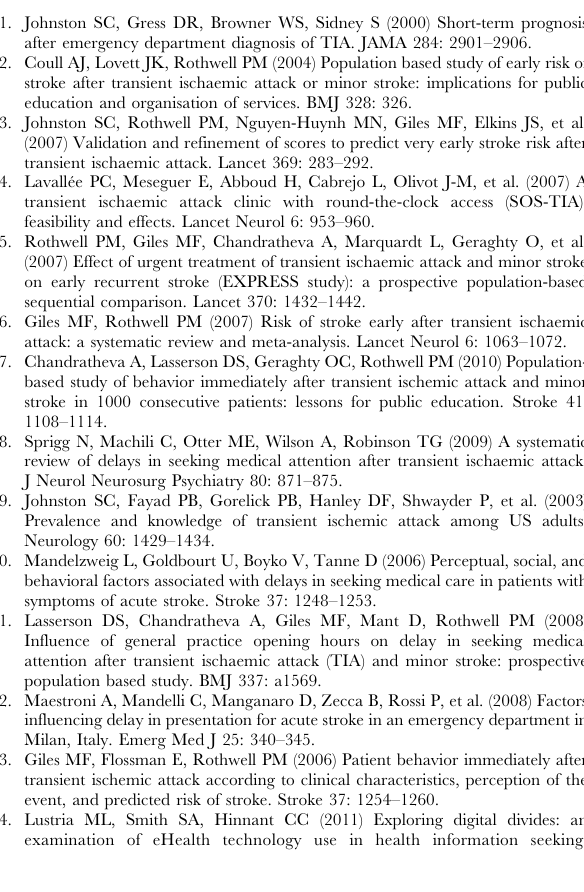
Table S1 Interrater agreement on cerebrovascular diagnosis. Agreement between two independent telephone assessments by vascular neurologists for the diagnosis of stroke/ TIA among 84 participant seeking information on TIA/stroke symptoms on the internet. Agreement for Stroke/TIA was 95.8% and the quadratic-weighted kappa was